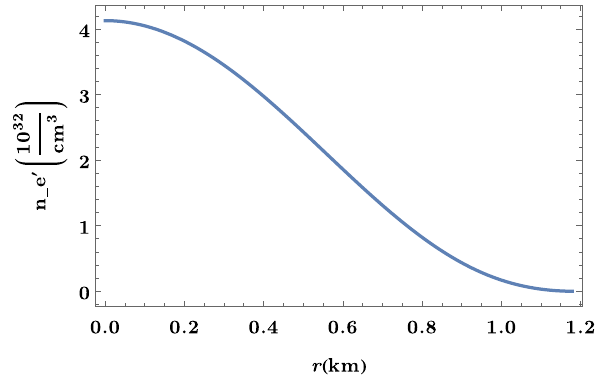
Fig. 2 n e (cid:2) as function of